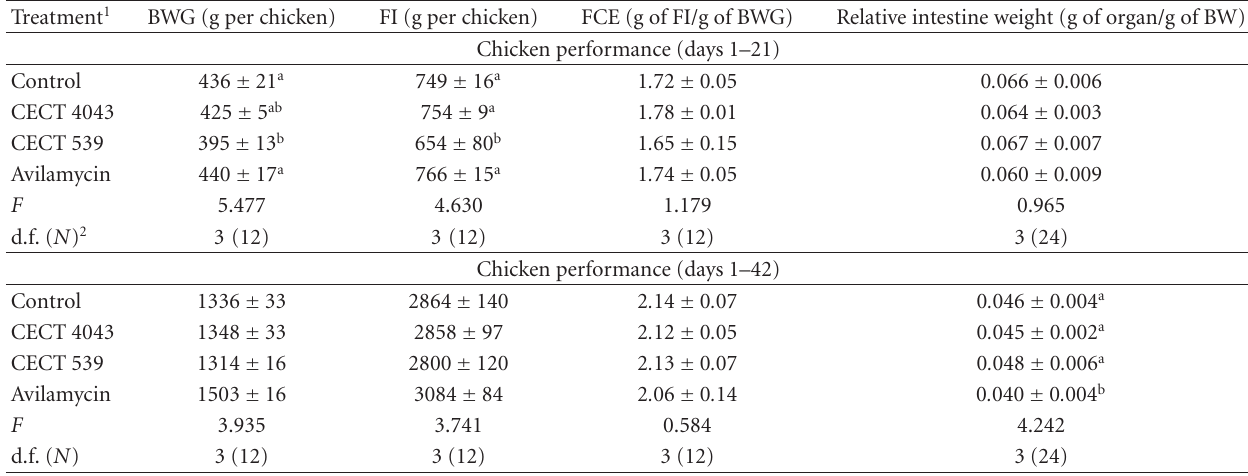
Table 3: E ff ect of dietary probiotic preparations (CECT 4043, CECT 539) or antibiotic (avilamycin) on growth performance parameters of medium-growth Sasso X44 chickens during 42 days (experiment